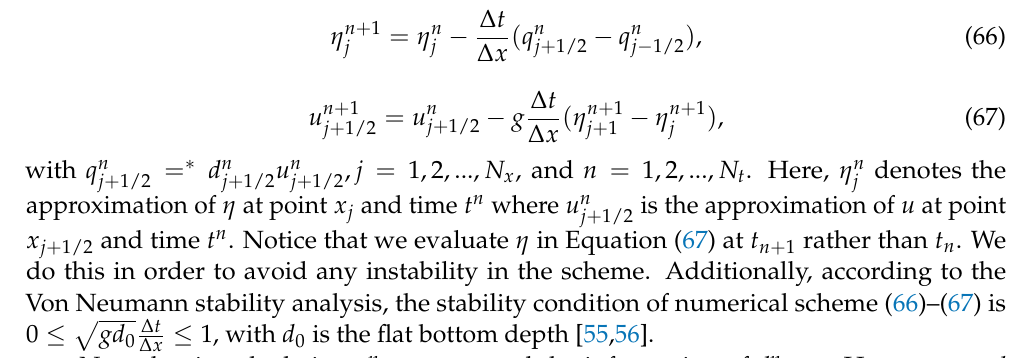
(cid:99) + 1 time steps by the t